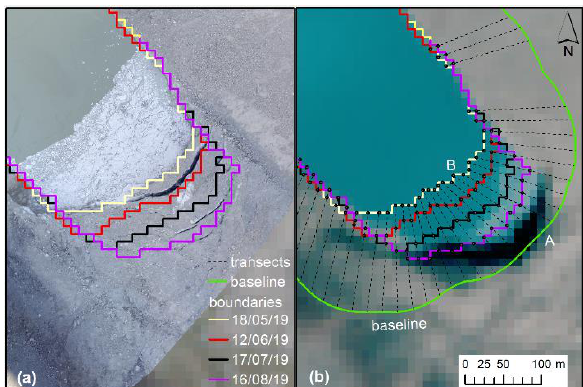
Figure 5. (a) Detailed view of the glacier terminus with the lake boundaries from the four Sentinel epochs, superimposed over (a) the UAV orthomosaic and (b) the false colour infrared composite of Sentinel-2 on 16-08-2019. Baseline and transects are indicated in (b) as constructed with the DSAS toolbox to estimate glacier retreat rate.